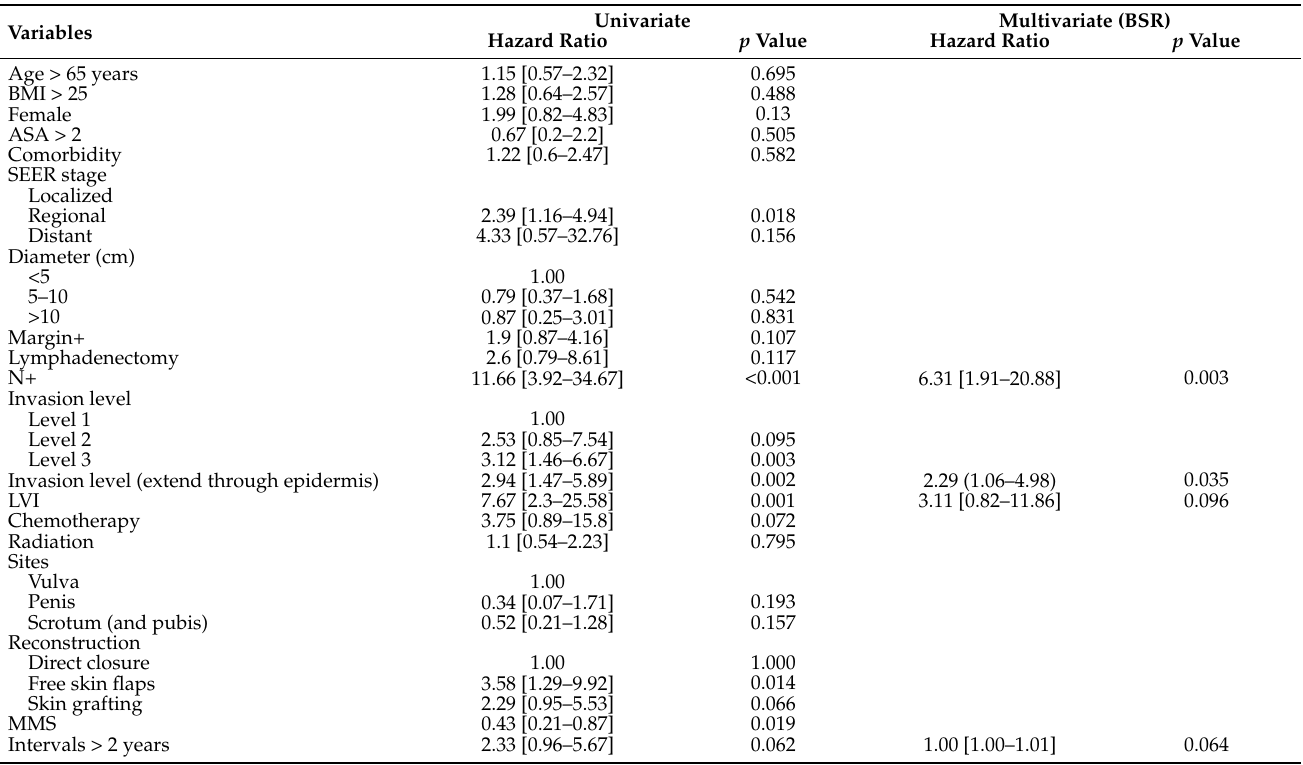
Table 2. Univariate and multivariate (backward stepwise) Cox regression for PFS in EMPD.